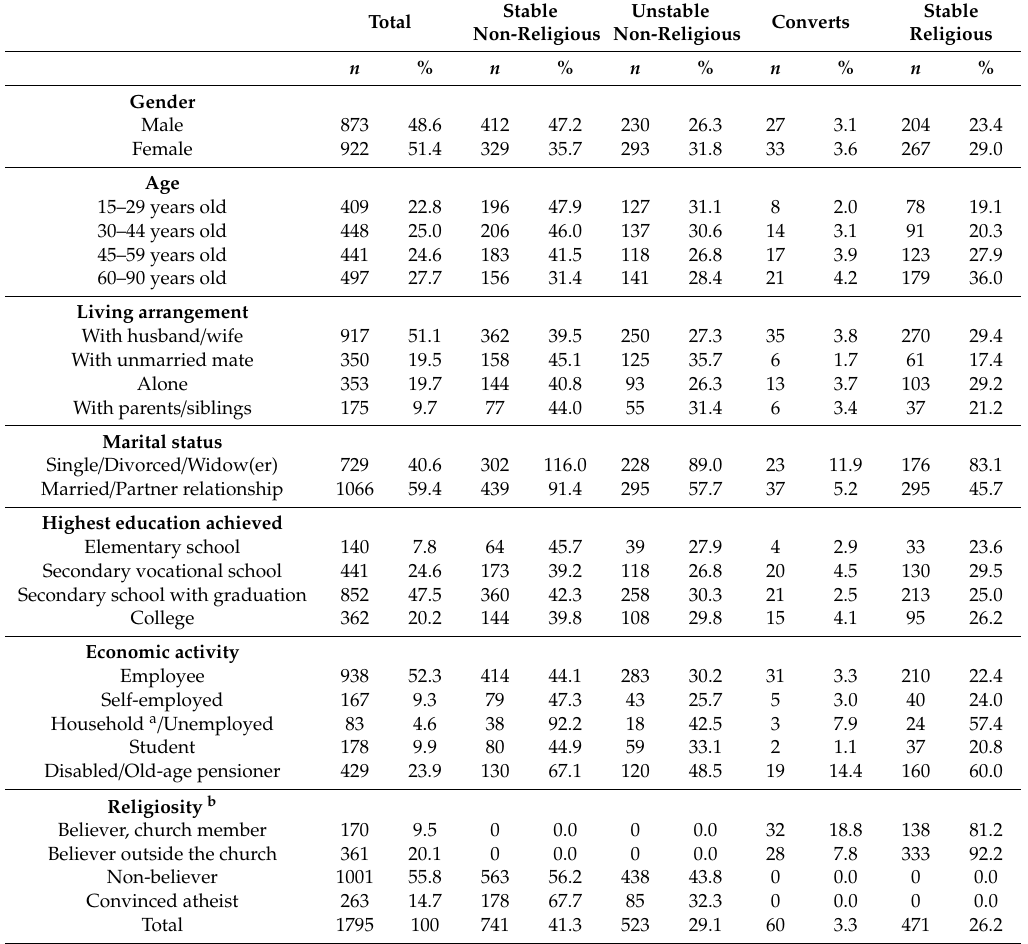
Table 1. Description of the study population, total and by stability of